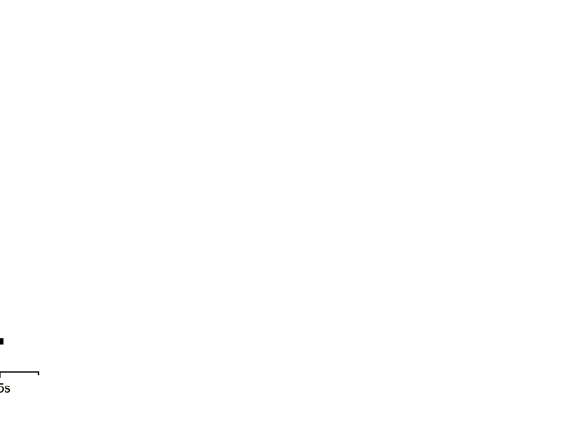
Figure 12. Maximum value of additional axial stress for different tubing diameters. (Uniform pump shutdown time of 6 s and inside pressure of 10 MPa).